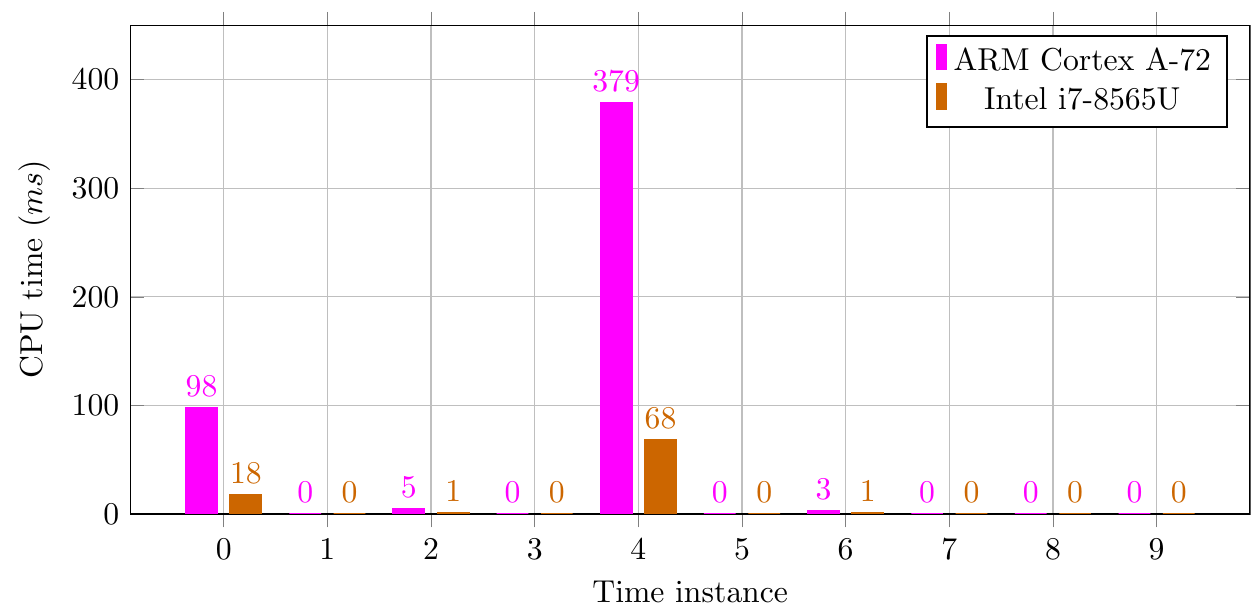
Figure 8. Employed CPU time for the computation of the AGV